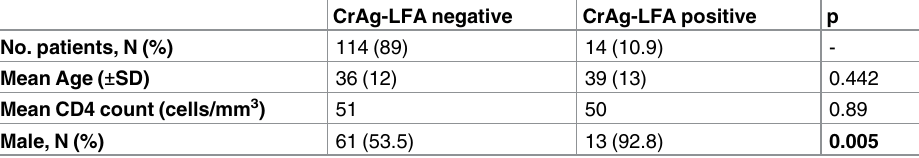
Table 1. Main characteristics of patients according to CrAg- LFA